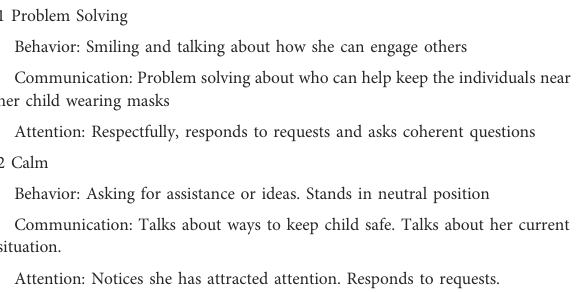
TABLE 2 Levels of behavior for Stacy. 1 Problem